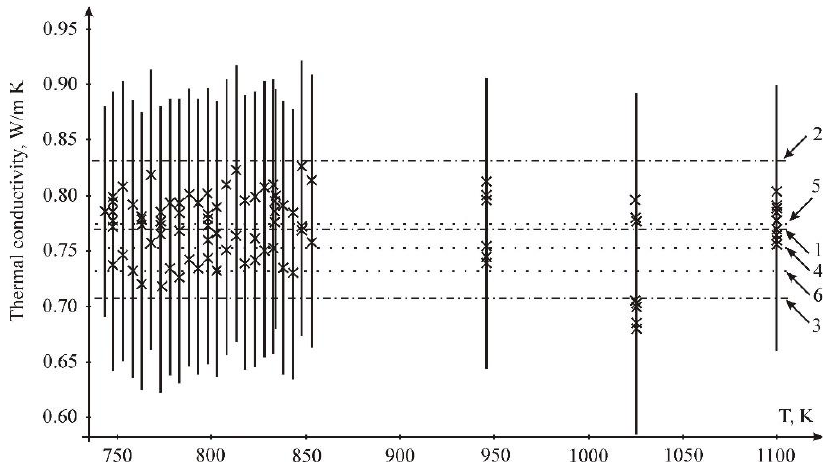
Figure 10. Fitting results for the thermal conductivity of the sample n = 96 measurements (×): 1 — mean value by LSQM 0.769 W/m K; 2 — mean value by LSQM + 2 Sigma W/m K; 3 — mean value by LSQM—2 Sigma W/m K; 4—Interval evaluation 0.753 W/m K; 5—Upper limit of